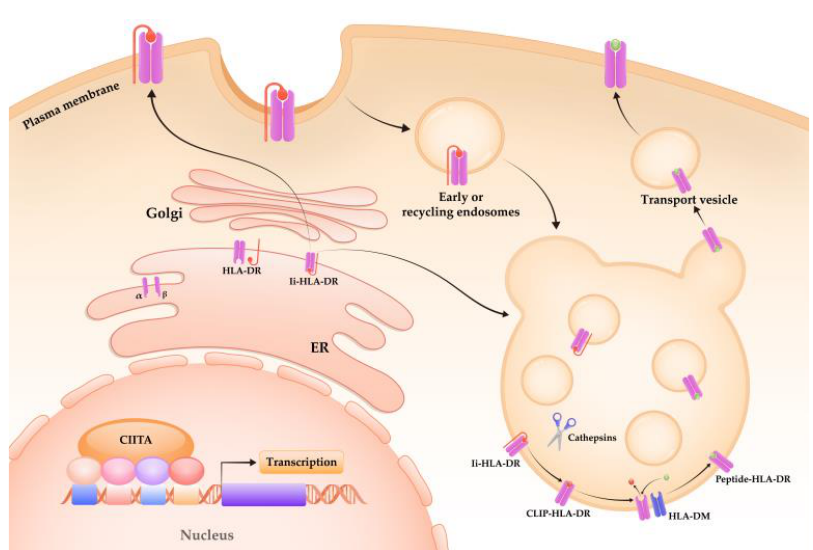
Figure 3. Regulation of mHLA-DR expression. Figure adapted from [105,111]. The transcription of HLA-DR is tightly regulated by a set of cis-acting regulatory promoter elements and transcription factors. Class II transactivator (CIITA) is the master transcriptional regulator. The α - and β -chains of HLA-DR assemble in the endoplasmic reticulum (ER) and then bind with the invariant chain (Ii). The Ii–HLA-DR complexes transport through Golgi complex to the MHC class II compartment (MIIC), directly or via the internalization of the plasma membrane. Ii is degraded into class II-associated Ii peptide (CLIP) via members of cathepsin family. In the aid of chaperone HLA-DM, CLIP is exchanged for antigen peptide. Peptide-HLA-DR complexes are then transported to the plasma membrane for further T cell activation. Interfering with the expression and activity of CIITA, Ii, cathepsins, HLA-DM, as well as the associated vesicle traffic, all result in alteration of the mHLA-DR